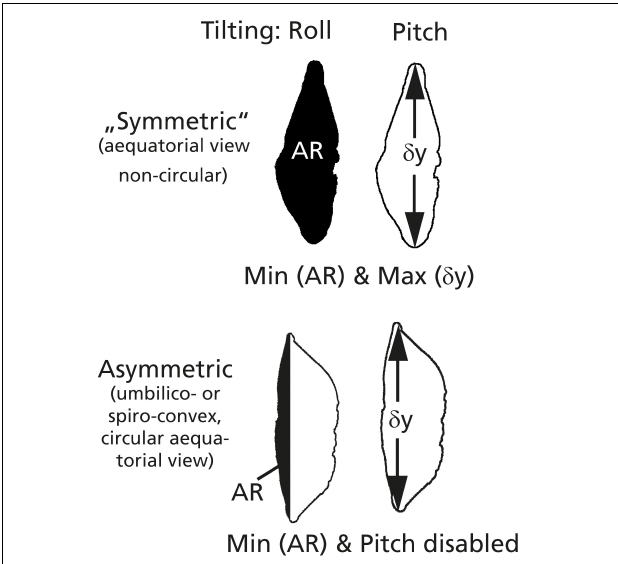
FIGURE 7 | Scheme for the orientation of particles into keel positions. In a symmetric case (above), the particle profile is biconvex and quasi-symmetric and has a non-circular periphery in an equatorial view (as in G. menardii ). The keel position is found if the profile area (AR) is minimized AND if the longest diameter ( δ y ) is maximized. In an asymmetric case ( Globorotalia miocenica , below), the spiral side is very flat and the shell has an almost circular periphery in an equatorial view. The keel position is found by minimizing the partial area (AR) on the spiral side, while the Pitch is disabled because δ Y is